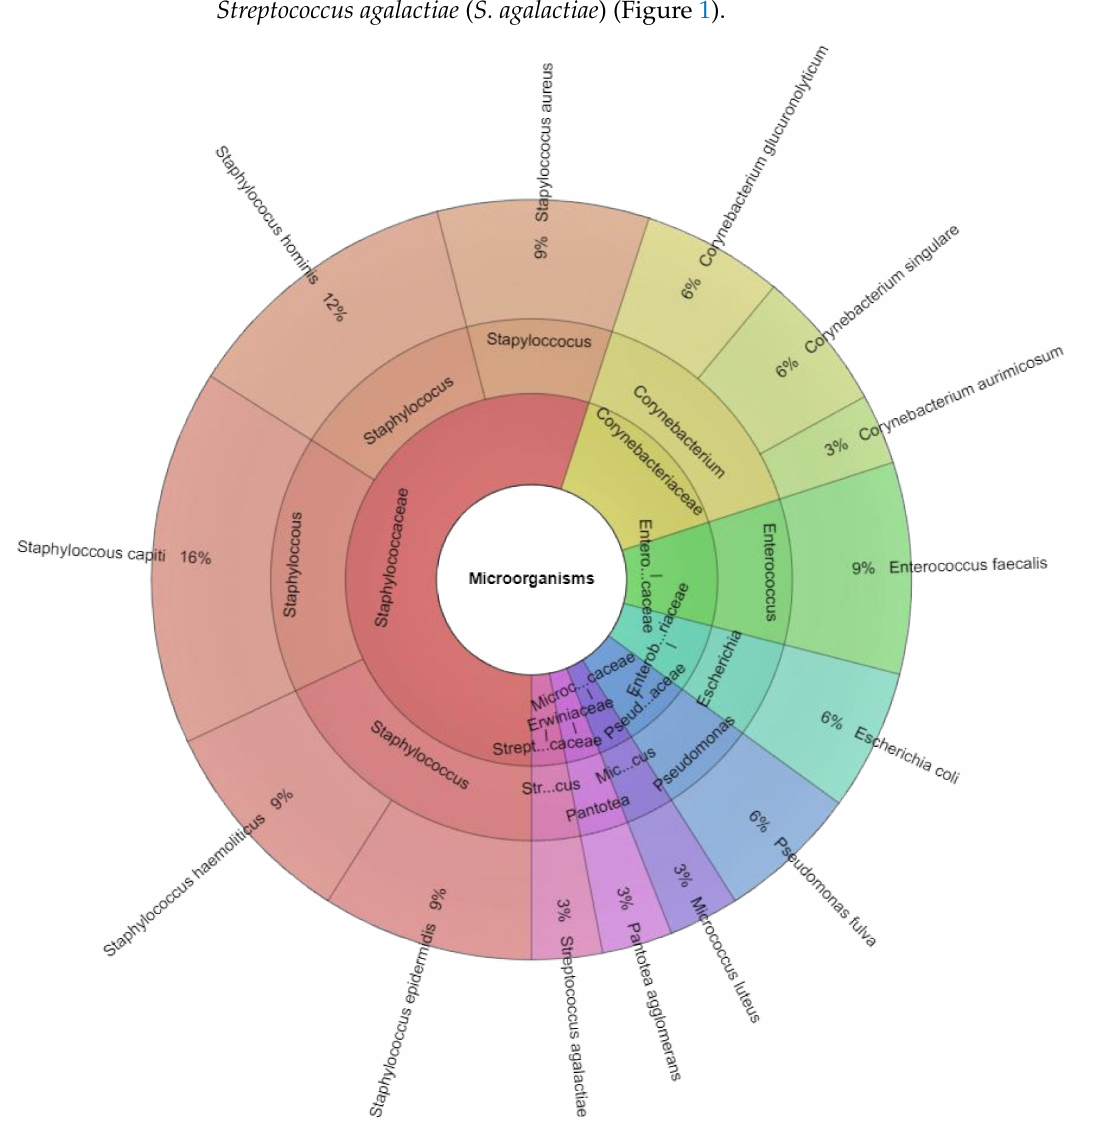
Figure 1. Krona chart of the bacteria identified by MALDI-TOF MS, recovered from human semen (innermost ring: family, middle ring: genus, outermost ring: